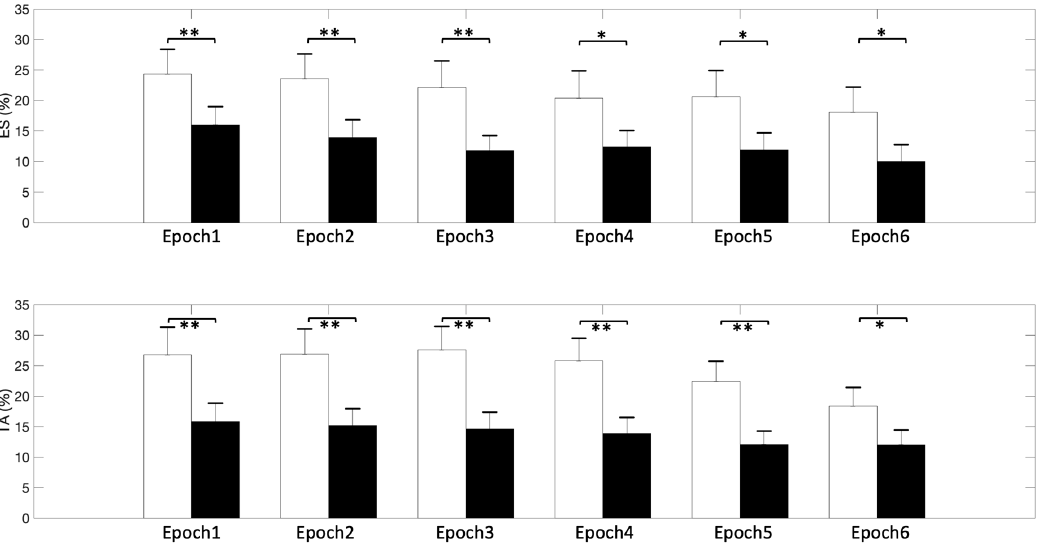
significant e ff ect of interaction between the factor of board and weight.